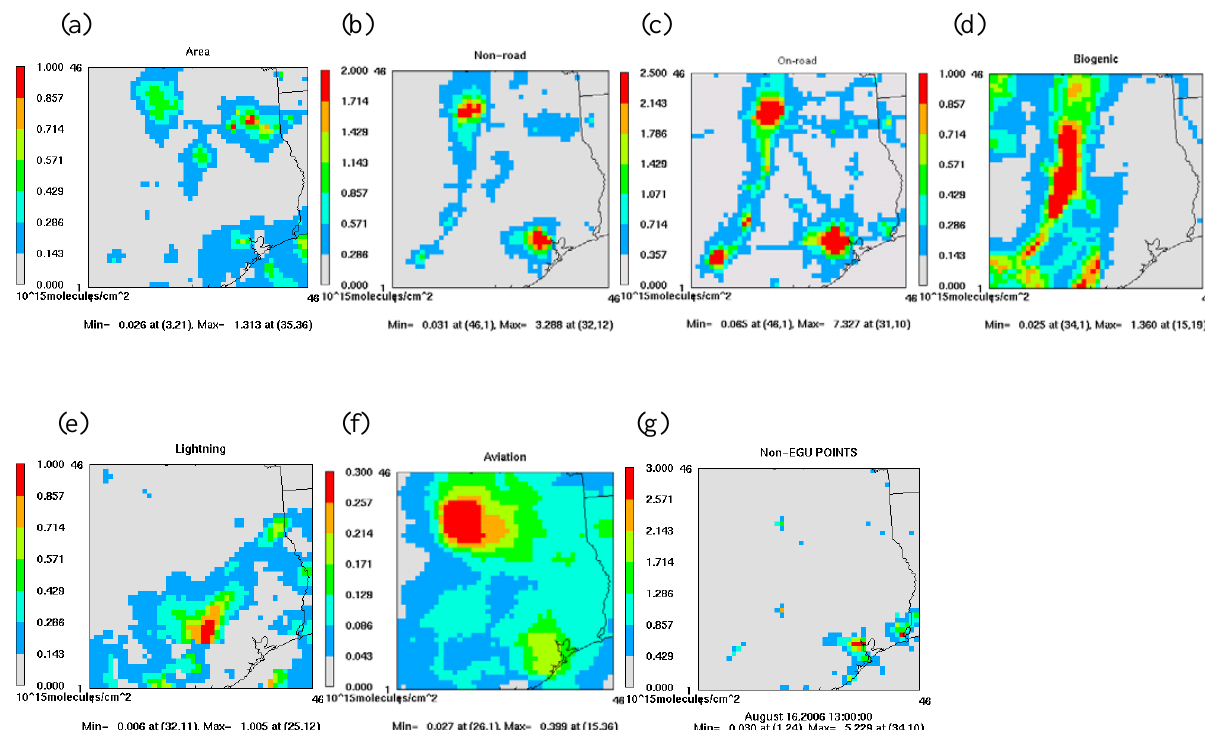
Figure 5. Vertical column densities of NO 2 sensitivities to NO x emissions of (a) area, (b) nonroad, (c) on-road, (d) biogenic, (e) lightning, (f) aviation, and (g) non-EGU points source sectors. Table 2. Scaling factors of region-based and sector-based